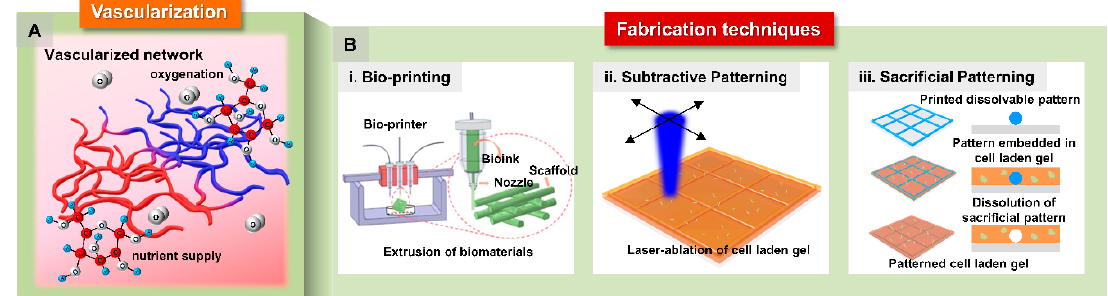
Figure 2. ( A ) Schematic illustration of vascularized network for efficient oxygenation and nutrient supply and removal of metabolic waste. ( B ) Fabrication-based approaches to engineering vascularized network: ( B , i ) bio-printing [23] © Copyright 2018, MDPI. ( B , ii ) subtractive patterning by laser ablation and ( B , iii ) sacrificial patterning using pre-defined dissolvable material.